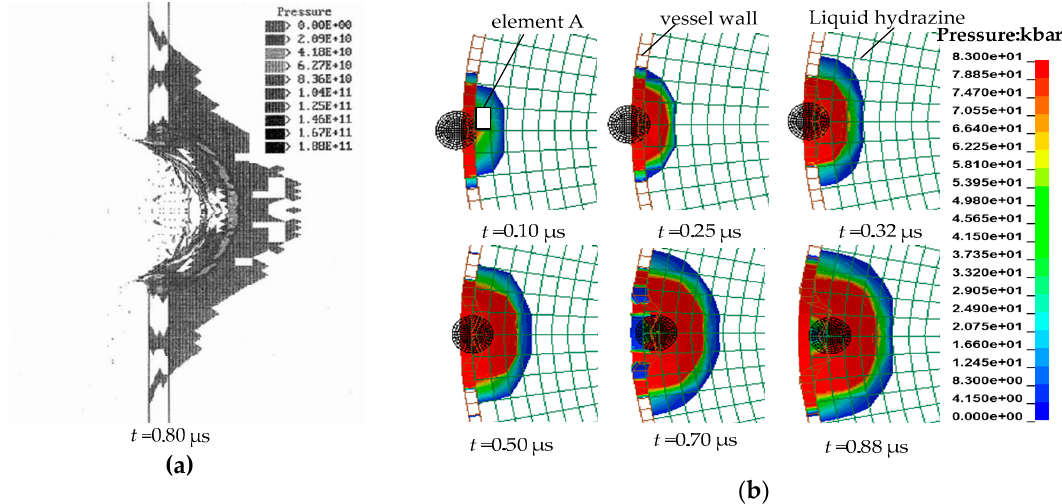
Figure 6. ( a ) Zeus calculation of the shock wave pressure and duration in liquid hydrazine [8]; ( b ) The pressure nephogram of the shock wave in liquid hydrazine obtained by ANSYS /